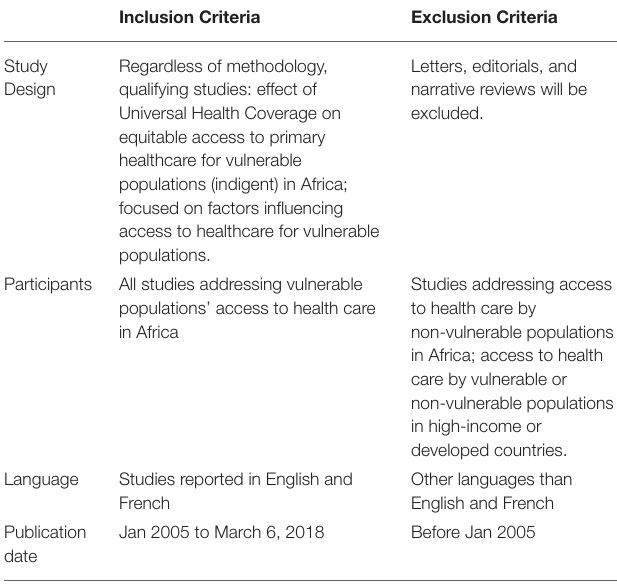
TABLE 1 | Systematic review inclusion and exclusion